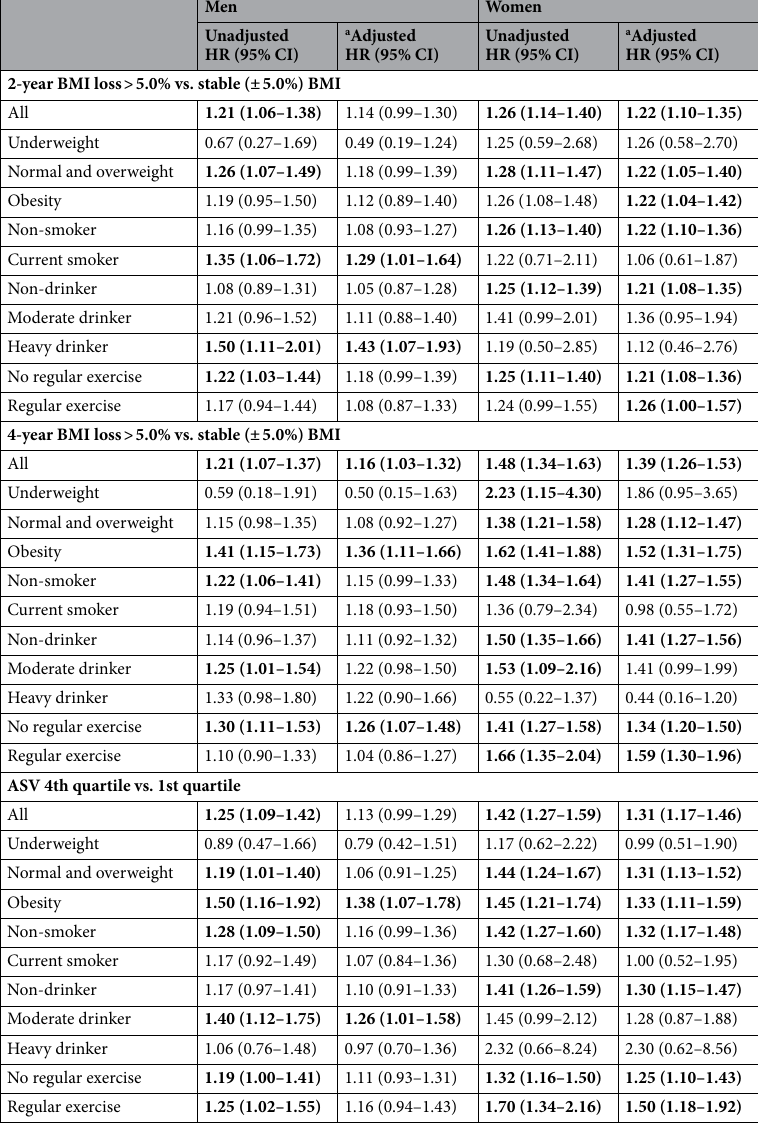
Table 4. Subgroup analysis for association between 2-year BMI loss, 4-year BMI loss, BMI variability and risk for Alzheimer’s disease according to lifestyle factors. BMI body mass index, HR hazard ratio, CI confidence interval, ASV average successive variability. a Adjusted for age, insurance premium, initial BMI, smoking status, alcohol consumption, regular exercise, hypertension, diabetes mellitus, and